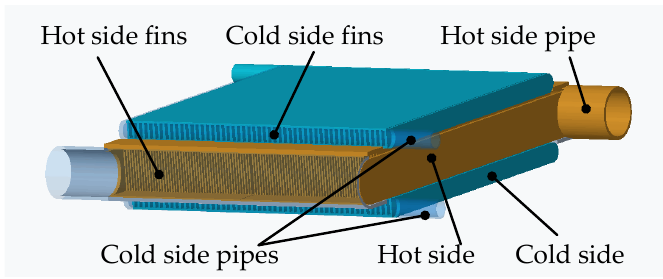
Figure 3. A 3D evaporator assembly drawing. Table 1. The experimental plate fin evaporator parameters.